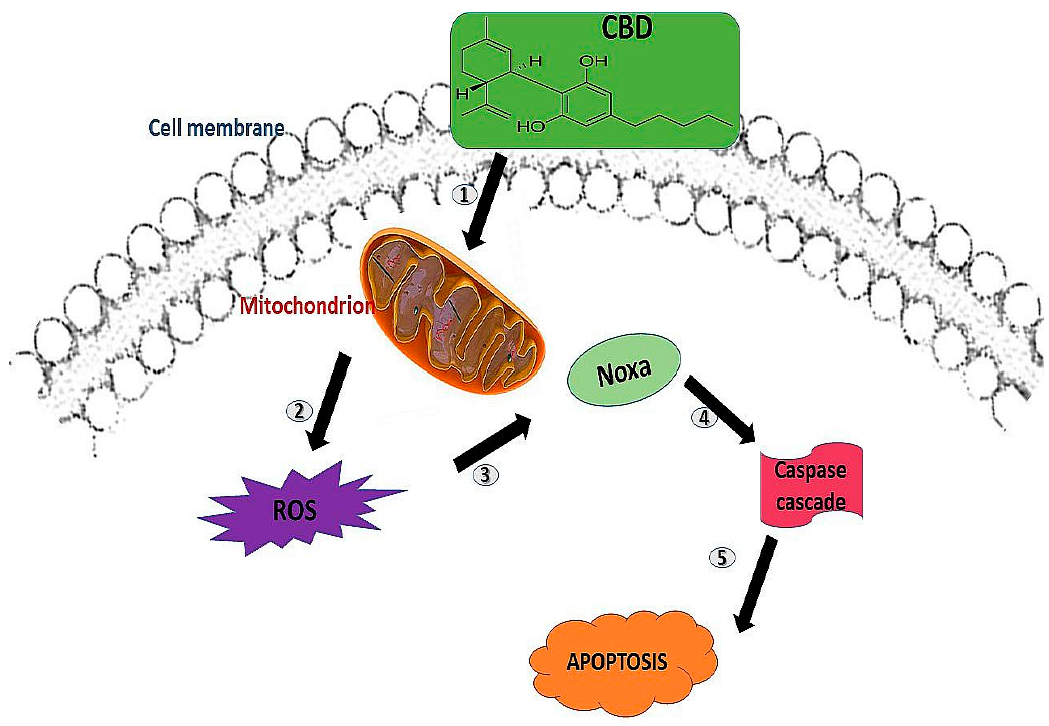
Figure 1. The proposed mechanism of cannabidiol (CBD) in inducing apoptosis. (1) CBD binds to the central and peripheral receptors on the cell membrane; (2) this results in mitochondrial stress and reactive oxygen species (ROS) production (3) leading to Noxa activation, and thus (4) the caspase cascade activation, which results in (5) apoptosis.